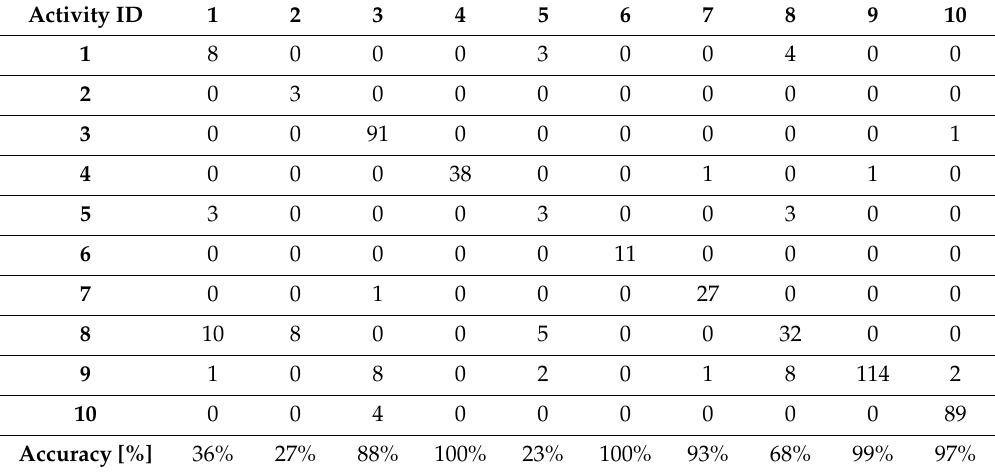
Table 6. Confusion matrix of LiSSA-RBF on dataset OrdonezB. The activity ID from 1 to 10 represents breakfast, dinner, grooming, leaving, lunch, showering, sleeping, snack, watching TV, toileting, respectively. Rows represent the inferred activity and columns represent the actual activity.